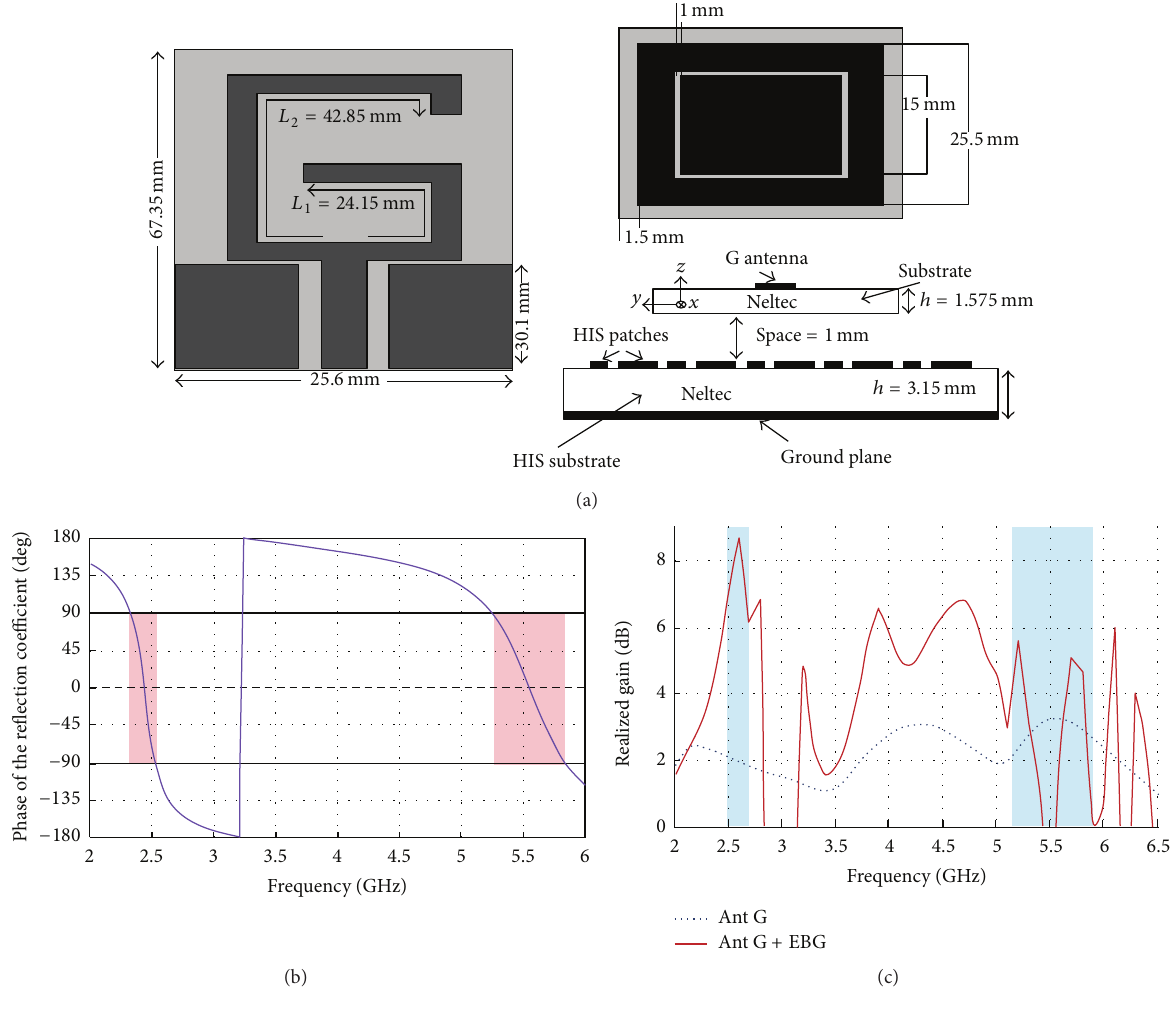
Figure 15: (a) G-shape antenna with concentric square EBG structure, (b) reflection phase of the EBG, and (c) comparison of realized